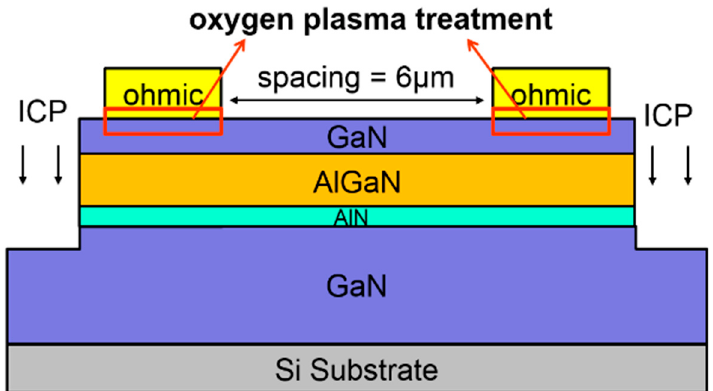
Figure 1. Cross-section views of the sample structure.